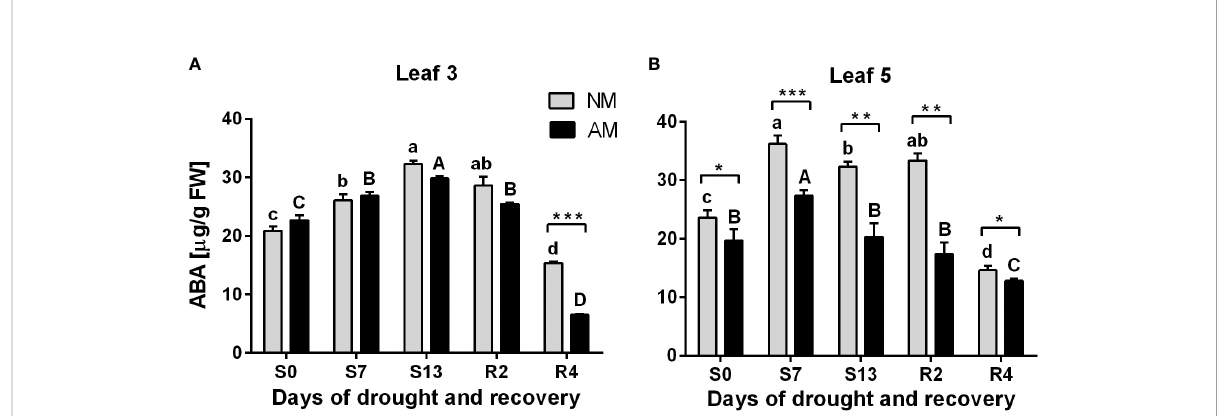
FIGURE 3 Abscisic acid (ABA) accumulation patterns for L3 (A) or L5 (B) leaves at subsequent time points of drought development (S0-S13) and rehydration (R2, R4), in relation to the presence (AM) or the absence (NM) of mycorrhiza. Bars represent mean values and standard error of mean (n=6). Statistically signi fi cant differences between AM and NM means, calculated using Students t -test are presented with asterisks (* p <0.05, ** p <0.01, *** p <0.001). Lower-case letters show signi fi cant differences between NM means and upper-case letters signi fi cant differences between AM means in following days, calculated using ANOVA test.